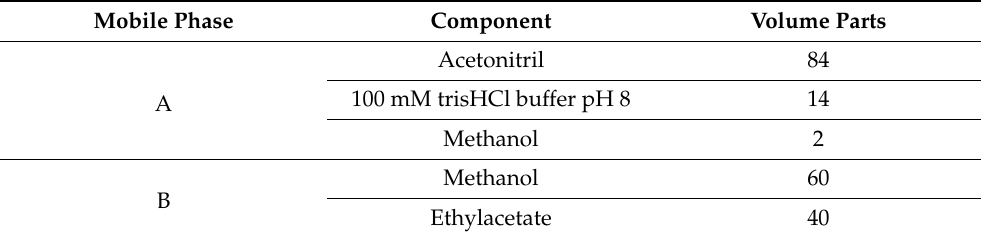
Table 6. Composition of mobile phases in HPLC analysis.